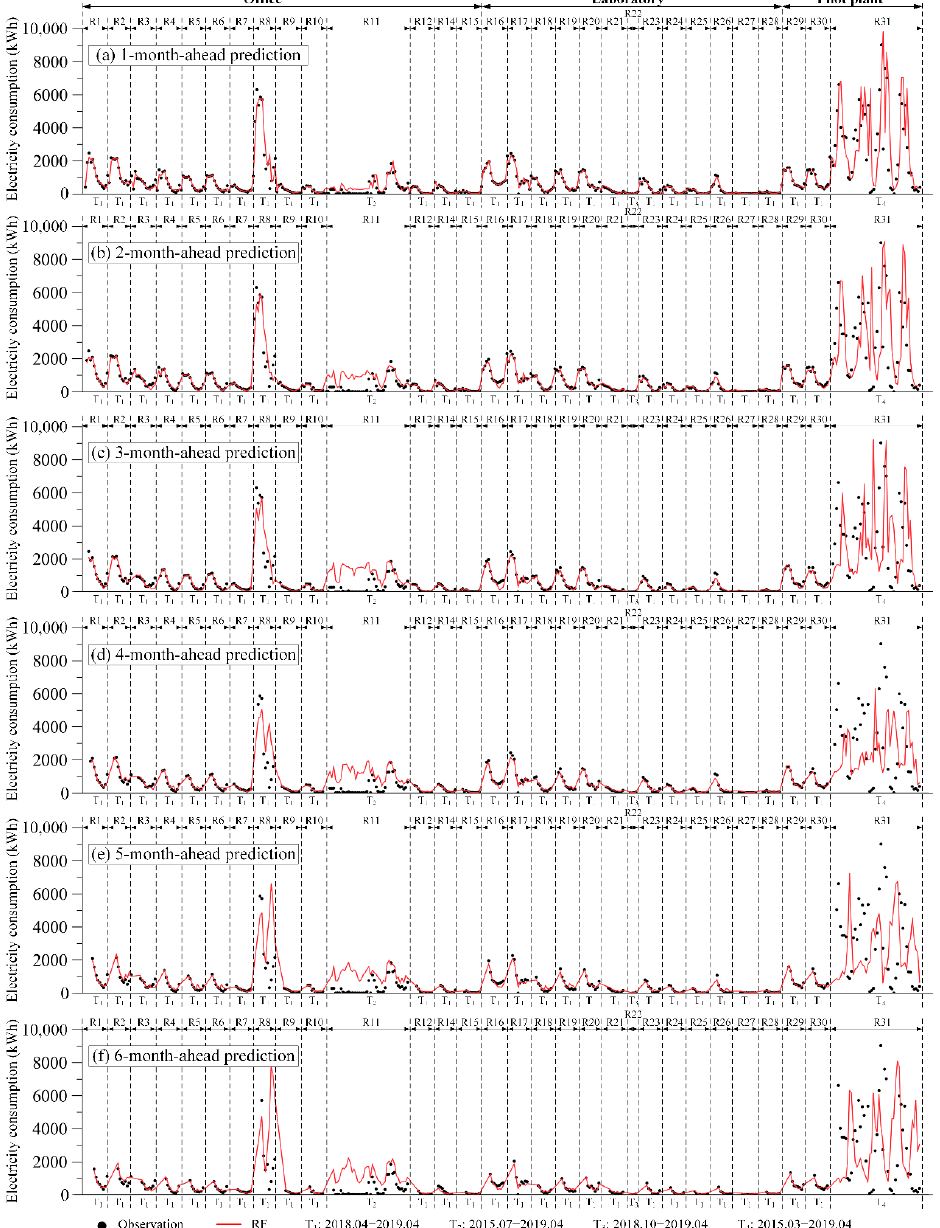
Figure 9. Comparison of the predicted electricity consumption with the ( a ) 1-, ( b ) 2-, ( c ) 3-, ( d ) 4-, ( e ) 5- and ( f ) 6-month-ahead predictions of the RF model in the testing phase.